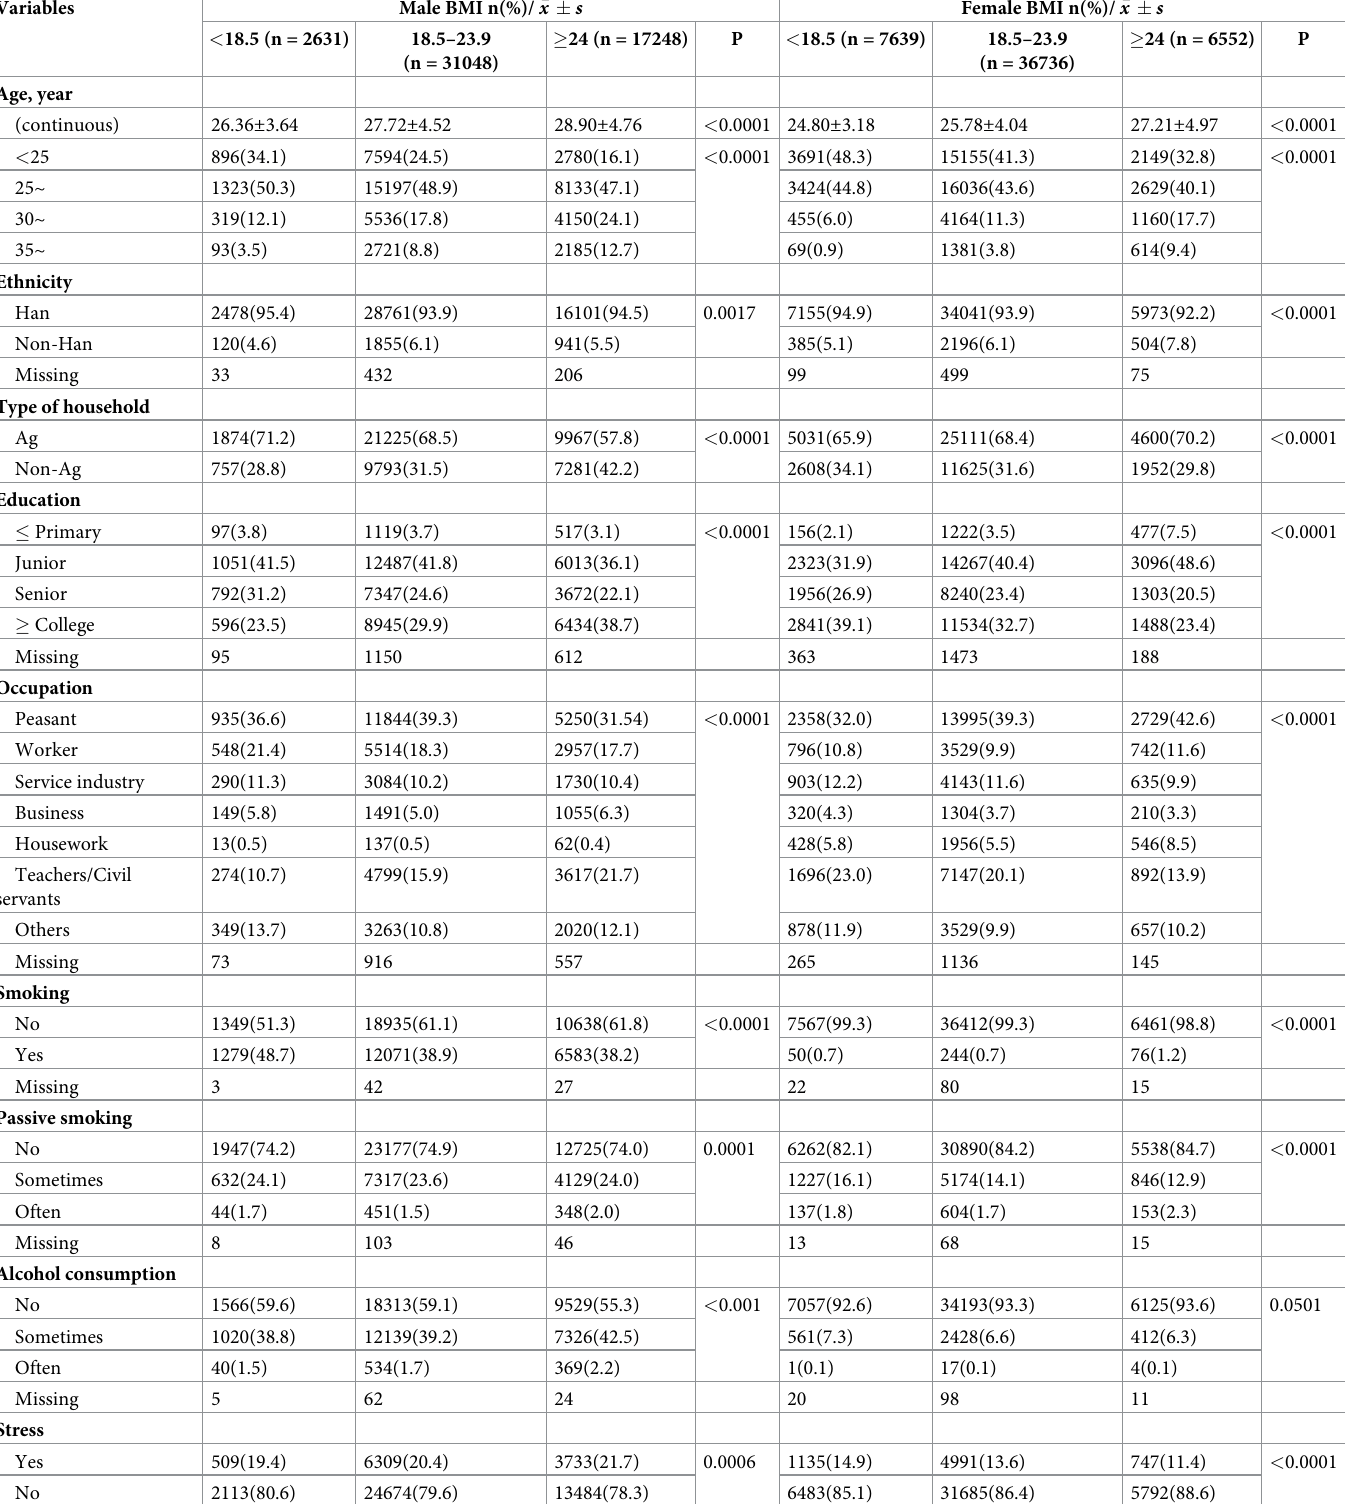
Table 1. Demographic characteristics of couples included in this study, stratified by BMI